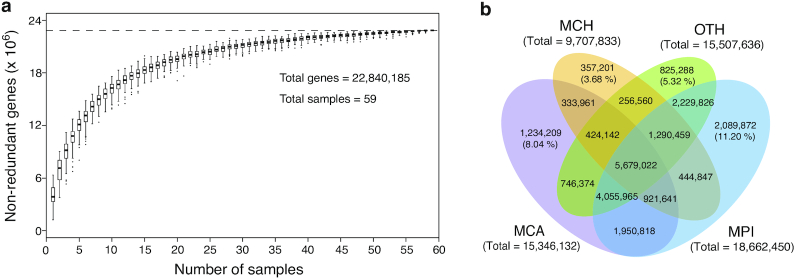
The constructed microbial gene catalog of anaerobic digestion (MGCA). a, Rarefaction curve of detected genes from the whole set of 59 digestate samples. The curve approaches saturation as sample number increases. The gene number of a given number of samples was calculated after 100 random samplings with replacement and plotted with a box plot. Box plots show the median ± interquartile range (IQR) and 1.5 IQR ranges (whiskers), with outliers denoted by circles. b, Venn diagram of shared genes among 4 groups of non-redundant genes from MCA, MCH, MPI, and OTH. Only a small proportion of genes were unique for each group. MCA: cattle manure BGPs; MCH: chicken manure BGPs; MPI: pig manure BGPs; OTH: BGPs with other substrates.